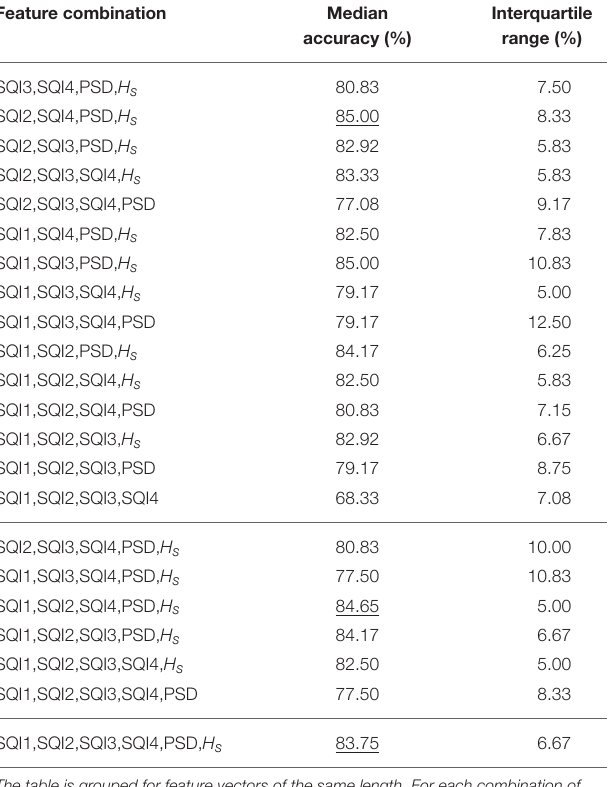
The table is grouped for feature vectors of the same length. For each combination of features, the median and interquartile range of the accuracy rate of the 100 repetitions are